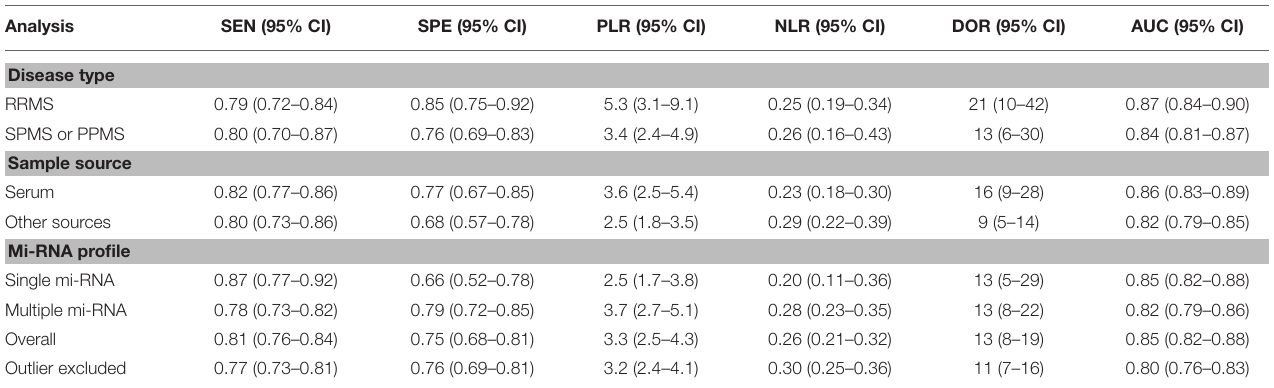
TABLE 2 | Summary estimates of diagnostic performance of miRNAs in NDs